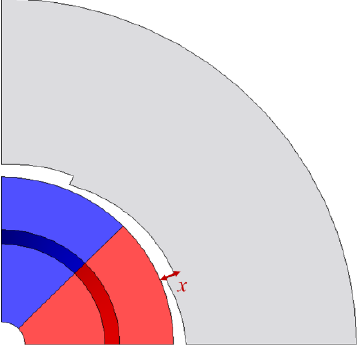
Figure 10. Selection of the design variable.